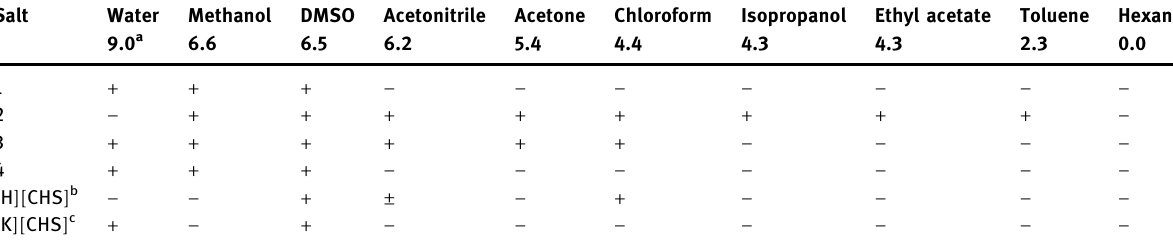
Table 3: Solubility of the prepared chlorsulfuron - based HILs ( 1 – 4 ) at 25°C Salt